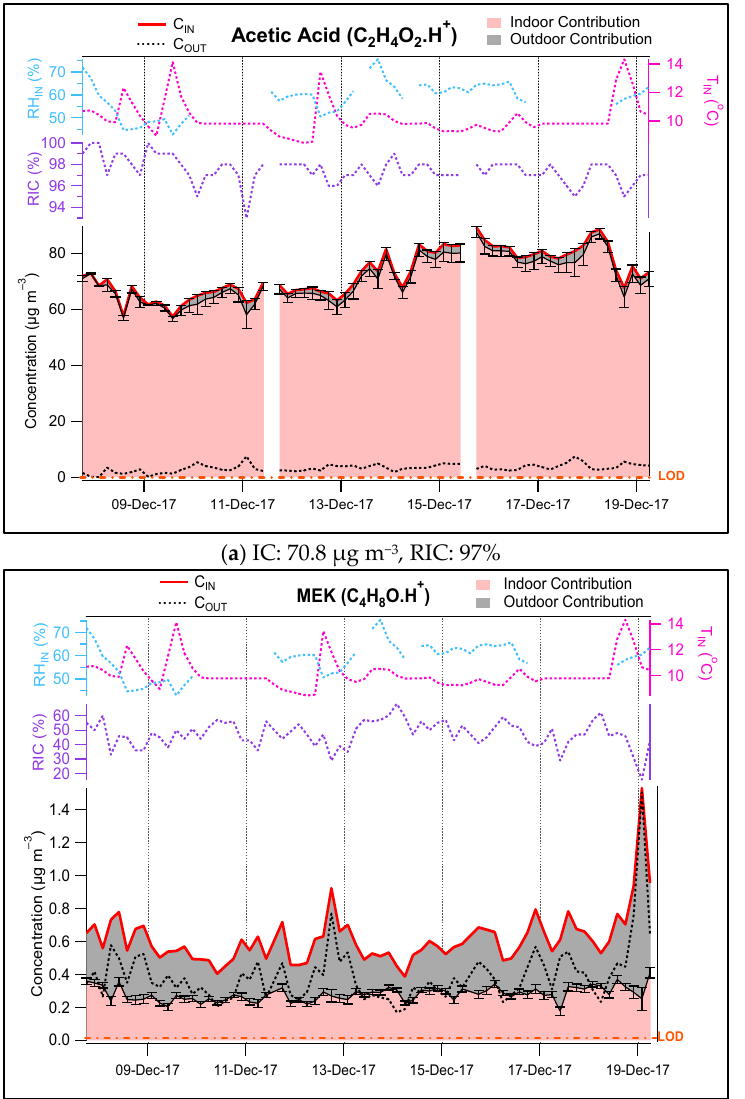
the C IN -C OUT scatter plot, which in turn may lead to an underestimation of the sink effect (overestimation of IC). (iv) The example of C8-aromatics (C 8 H 10 .H + ; Figure 6d) is also interesting because the time series of indoor and outdoor concentrations are very close and covary together over time, suggesting that these compounds are only of outdoor origin. However, the same figure also shows that the indoor environment contributes to approximately 30% of the indoor concentration. These contrasting observations are likely due to a compensation between a penetration factor lower than unity and the presence of small indoor emissions. The average relative indoor (RIC, in pink) and outdoor (ROC, in grey) contributions for all compounds measured during the intensive campaign are displayed in Figure 7. They are also reported in Table S6, together with the slopes of C IN -C OUT scatter plots and absolute indoor contributions (IC).